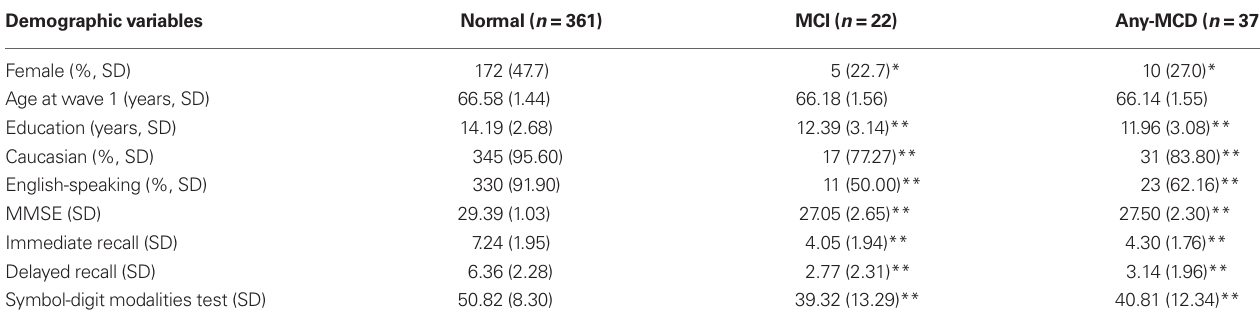
Table 1 | Demographic and Neuropsychological characteristics of the normal, MCI, and any-MCD sub-samples. Demographic